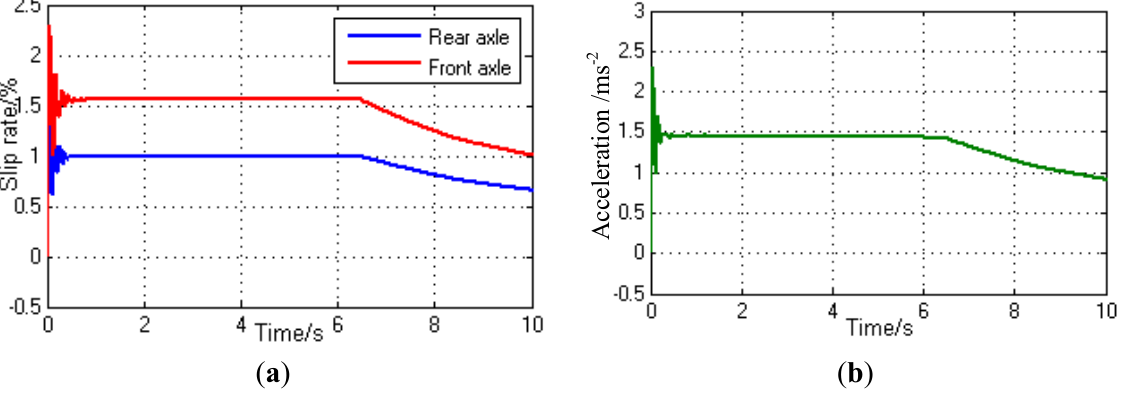
Figure 5. Simulation results of average distribution of inter-axle torque on good roads: ( a ) The front and rear axle tyre slip rate; ( b ) Vehicle acceleration.